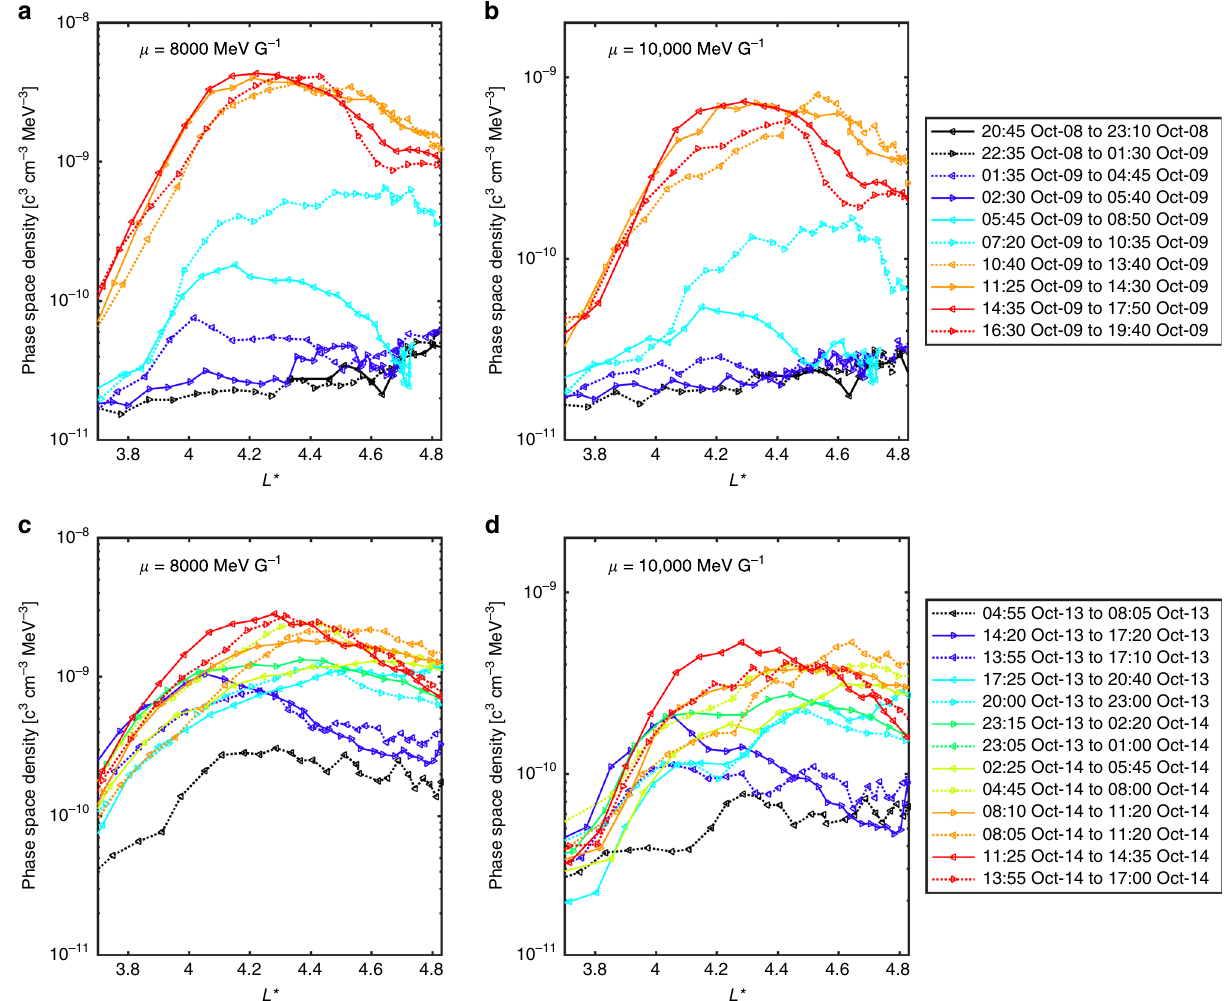
Fig. 5 Radial pro fi les of phase space density during the fi rst and second storm. Phase space density — L * pro fi les measured by Van Allen Probe A (solid lines) and B (dotted lines) are shown. a , b Show the phase space density during the fi rst enhancement period for μ = 8000 MeV and μ = 10,000 MeV, respectively. c , d Again show the phase space density for μ = 8000 MeV and μ = 10,000 MeV, respectively, but for the second enhancement period. Growing peaks are observed, indicative of local acceleration. All phase space density values correspond to K = 0.11 R E G 1/2 . Arrows mark the direction of spacecraft travel and we have used the maximum radius of the orbit (from the x , y , z coordinates) to distinguish between the inbound and outbound sectors of the pass. For each pass, the time of the fi rst and last measurement shown is used to label the phase space density — L * pro fi le. Not all passes are shown here and for additional passes see Supplementary Figs. 5 and